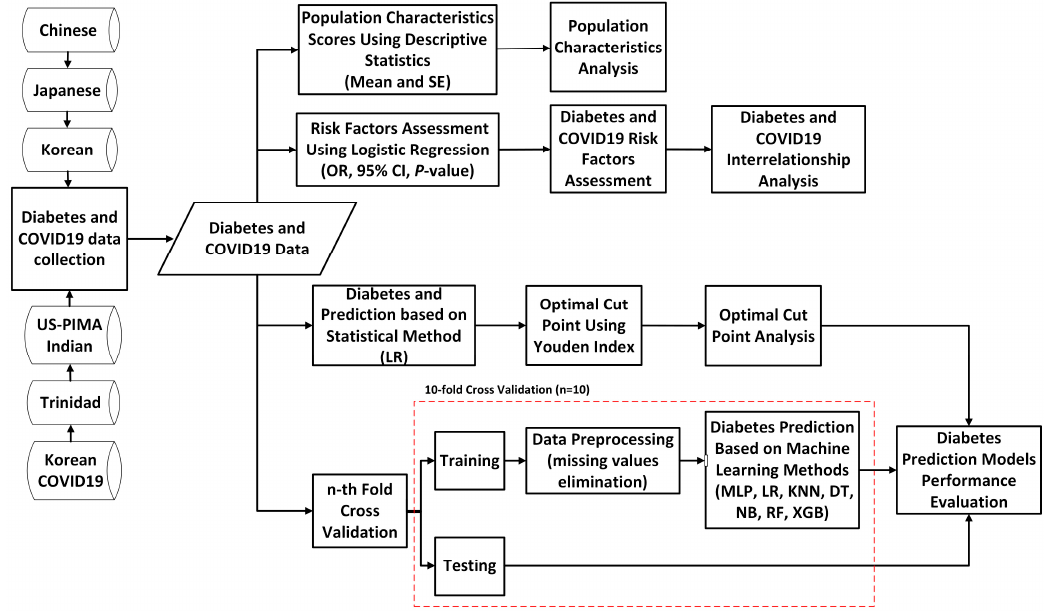
Figure 1. A flowchart of the proposed study design.